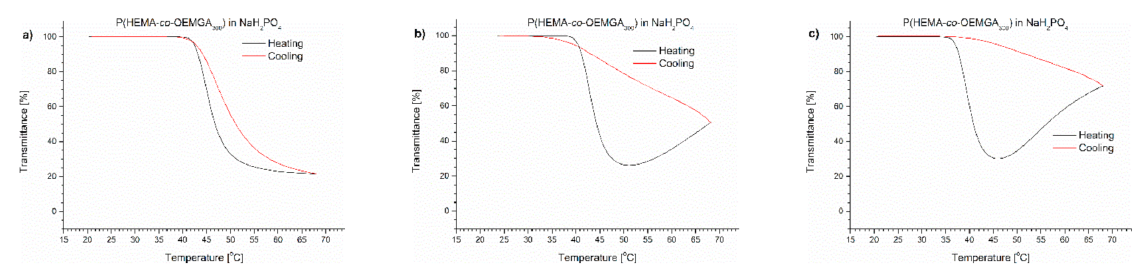
Figure 5. Transmittance versus temperature curves of solutions of P(HEMA- co -OEGMA 300 ) in ( a ) monosodium phosphate, ( b ) disodium phosphate, ( c ) NaCl. Total solute concentration: 0.5 g/L; heating/cooling rate: 1 ◦ C/min. Heating: black; cooling: